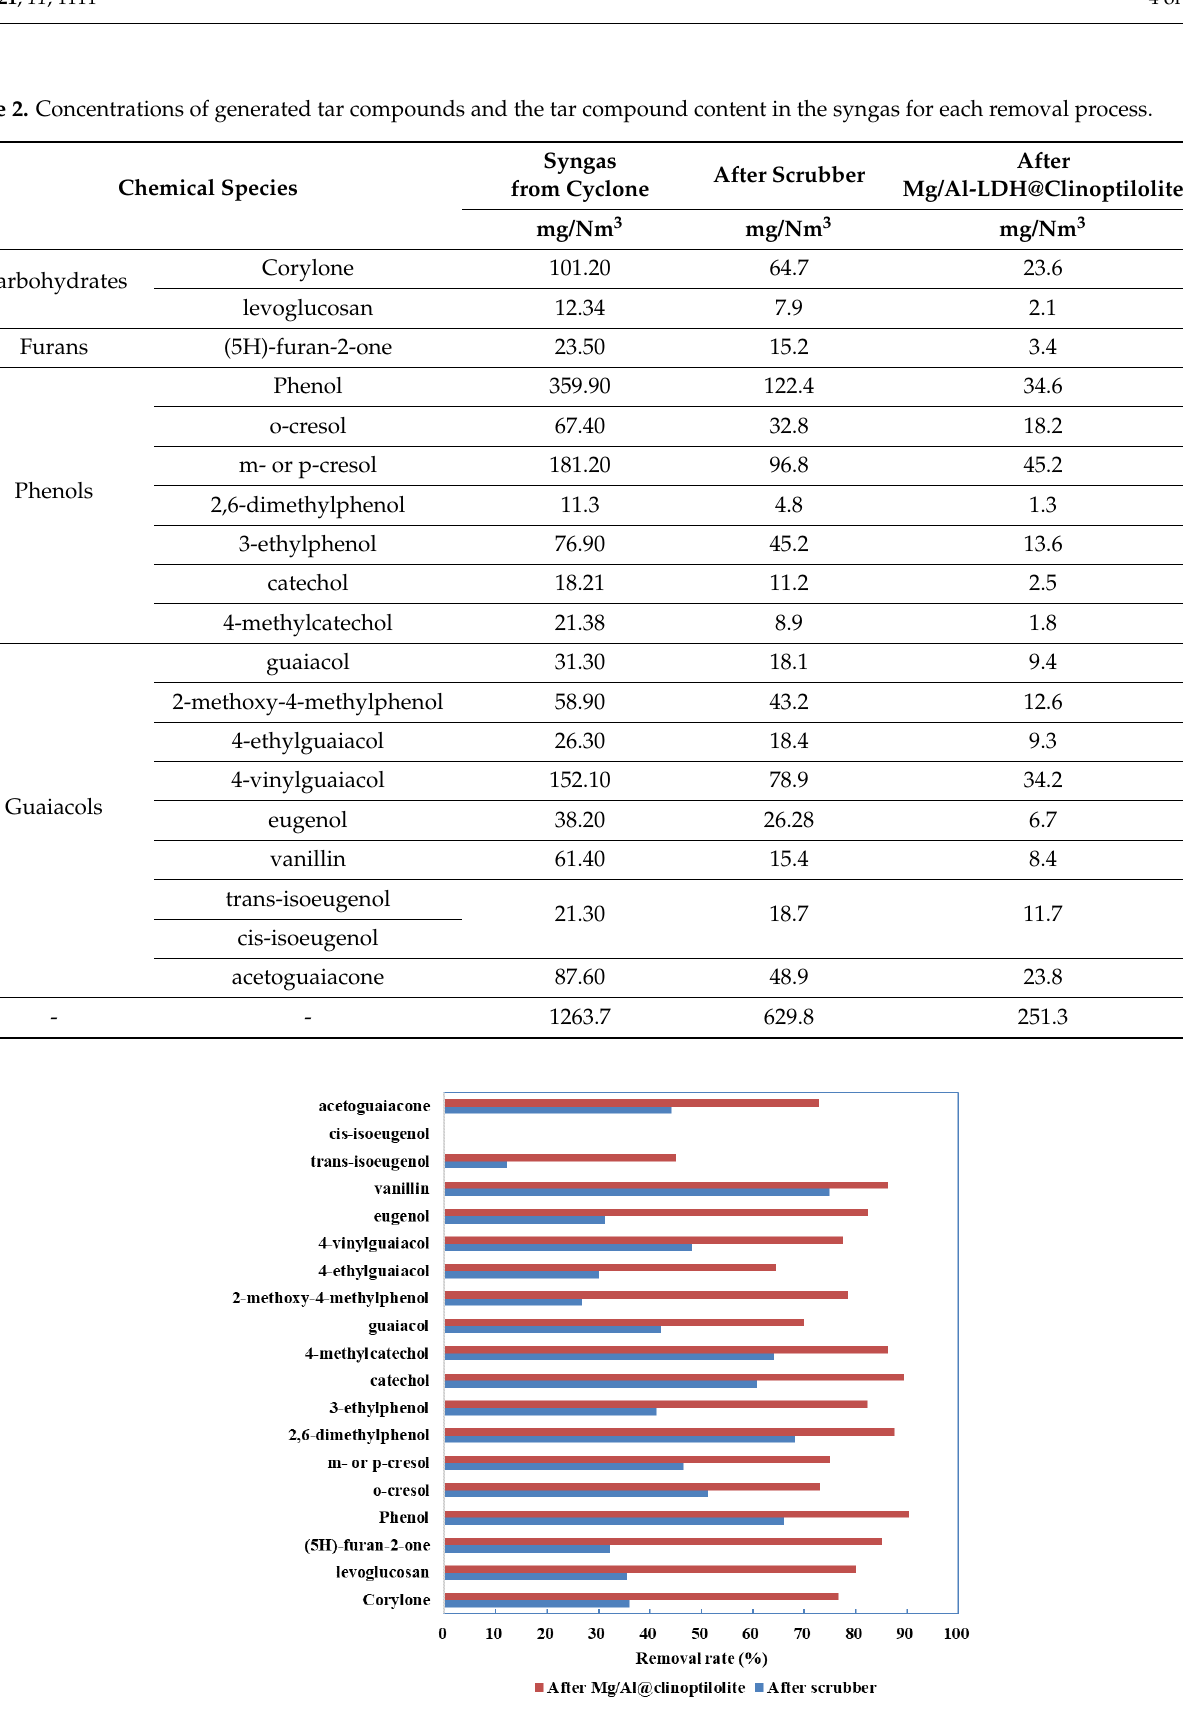
Figure 2. Comparison of removal rates for each tar compound in the syngas that passed through the water scrubber and Mg/Al-LDH@clinoptilolite.